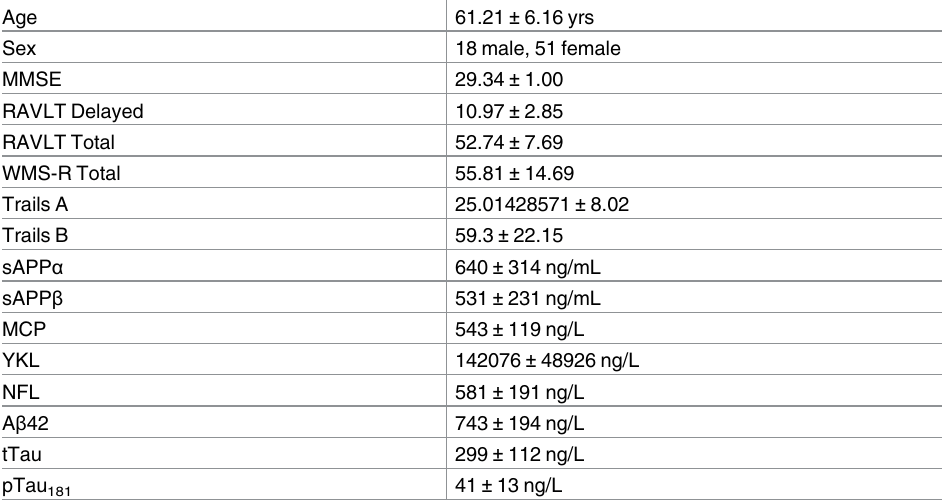
Table 1. Summary demographics, cognitive data, and CSF measuresfrom the included